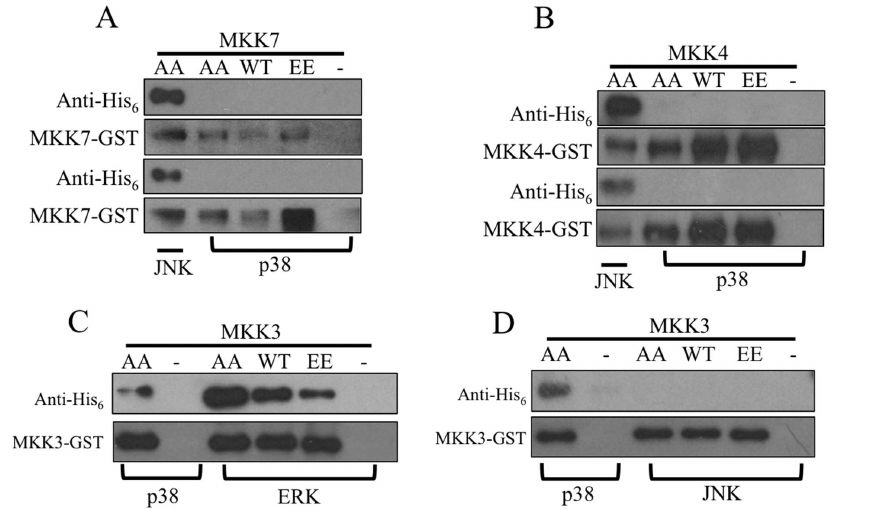
Figure 4. Binding dynamics might form the basis of MKK specificity. To further check the specificity of the interactions between MKKs and MAPKs, binding assays were conducted. MKKs and MAKPs were detected using antibodies against GST and His 6 tag, respectively. Negative control, which included MAPK alone with GST beads, and positive control, which included MKK protein interacting with a known MAPK partner, were conducted simultaneously. (A) MKK7 did not bind p38MAPK. (B). MKK4 did not bind p38MAPK. (C) MKK3 bound ERK. (D). MKK3 did not bind JNK.